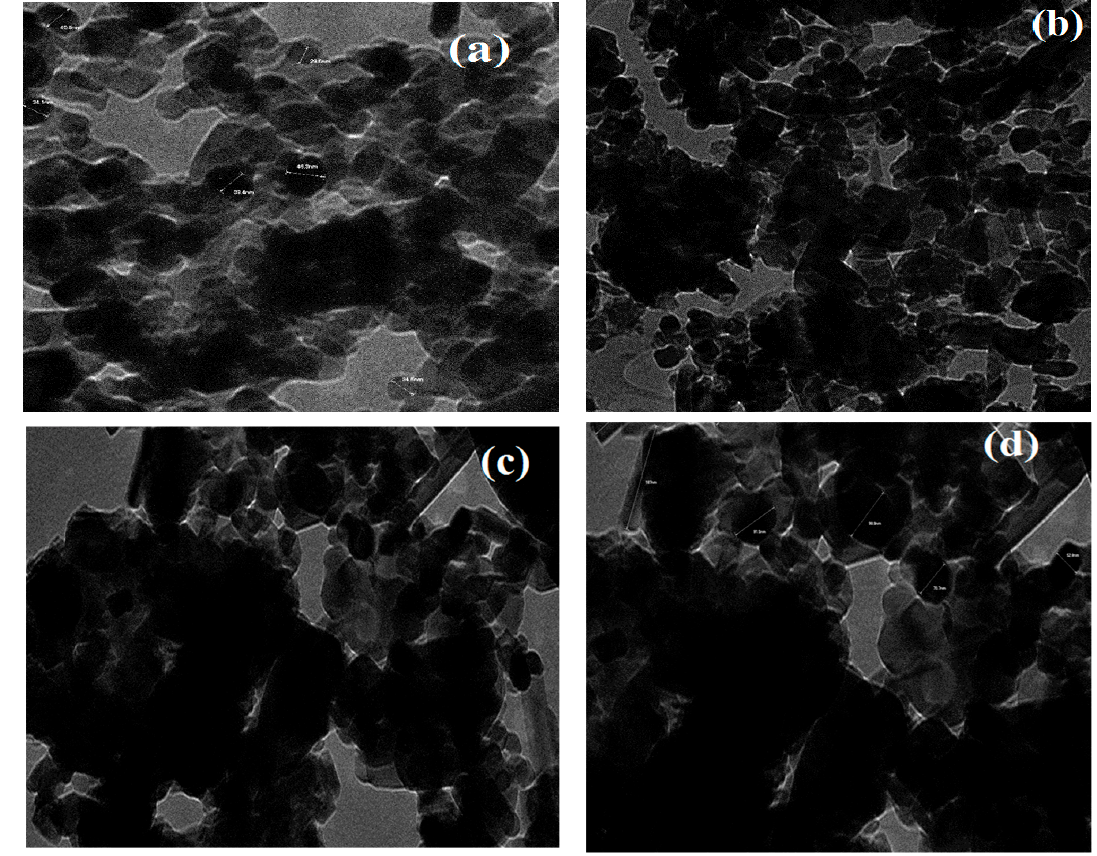
Figure 3. TEM images of ( a ) TiO 2 , ( b ) TiO 2 -0.25Li, ( c ) TiO 2 -0.5Li, and ( d ) TiO 2 -0.75Li.